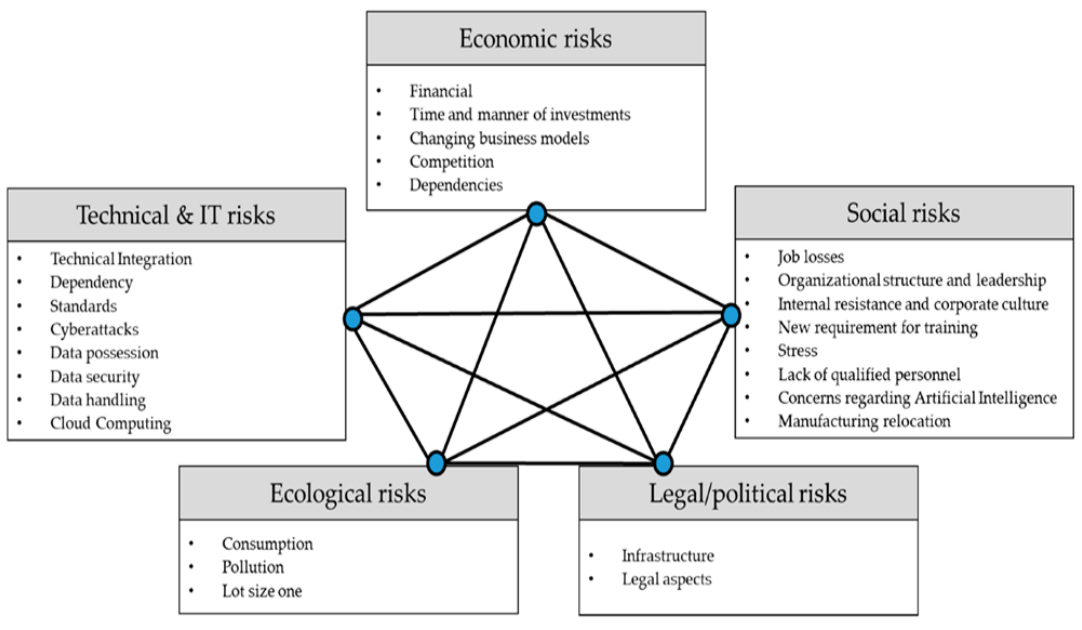
Figure 1: Industry 4.0 risk framework²